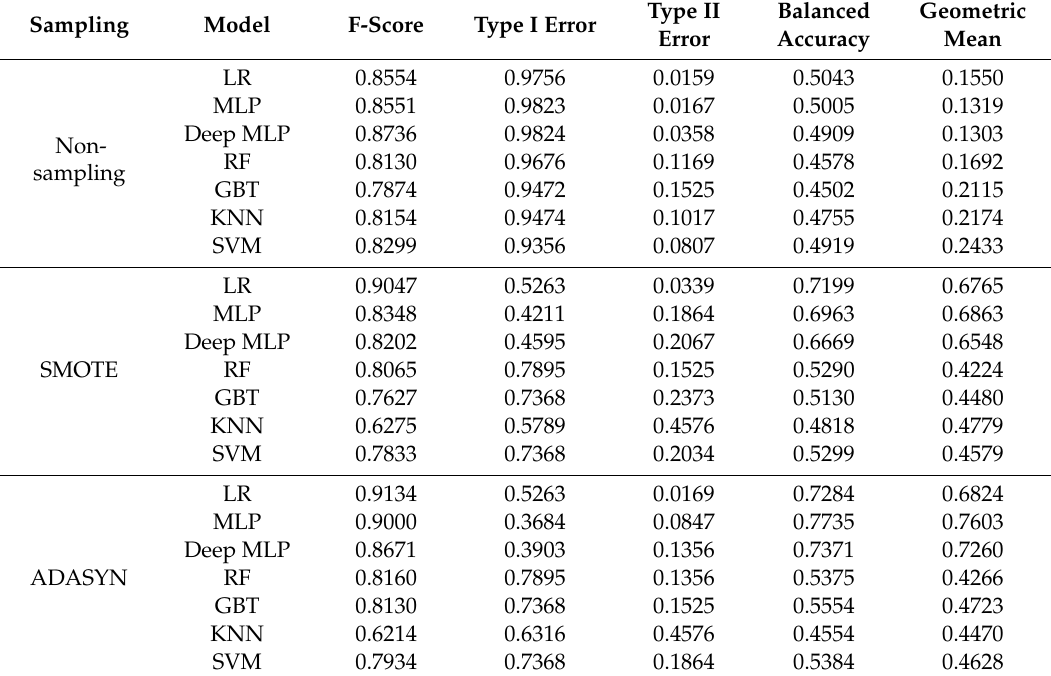
Table 5. Evaluation results of the prediction models among